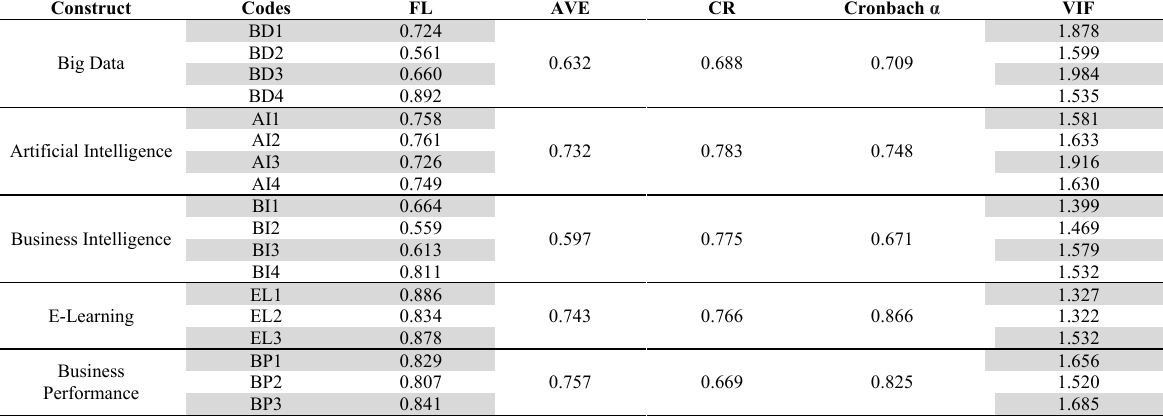
The summary of the results for the reliability and